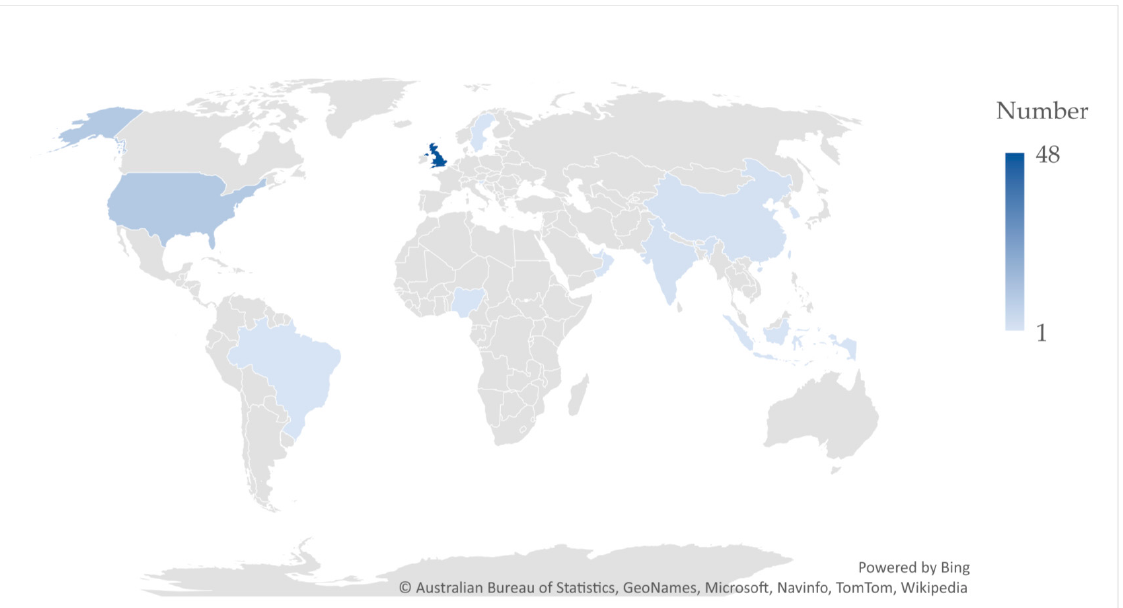
Figure 2. Annual number of scientific articles published between 2000 and 2020.